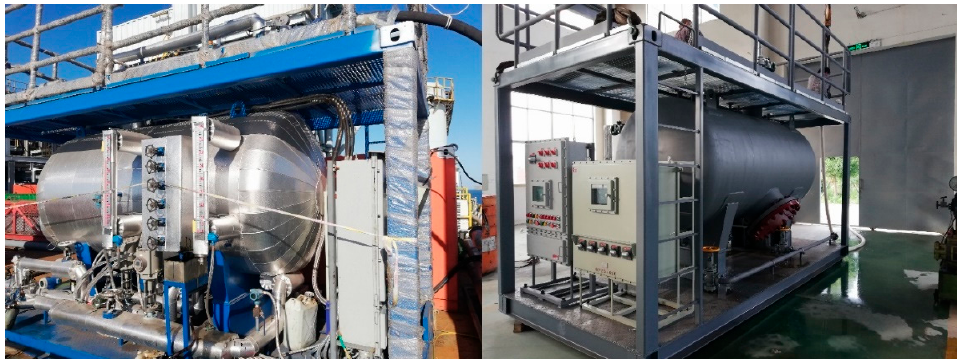
Figure 8. Schematic diagram of the overall structure of the test prototype.